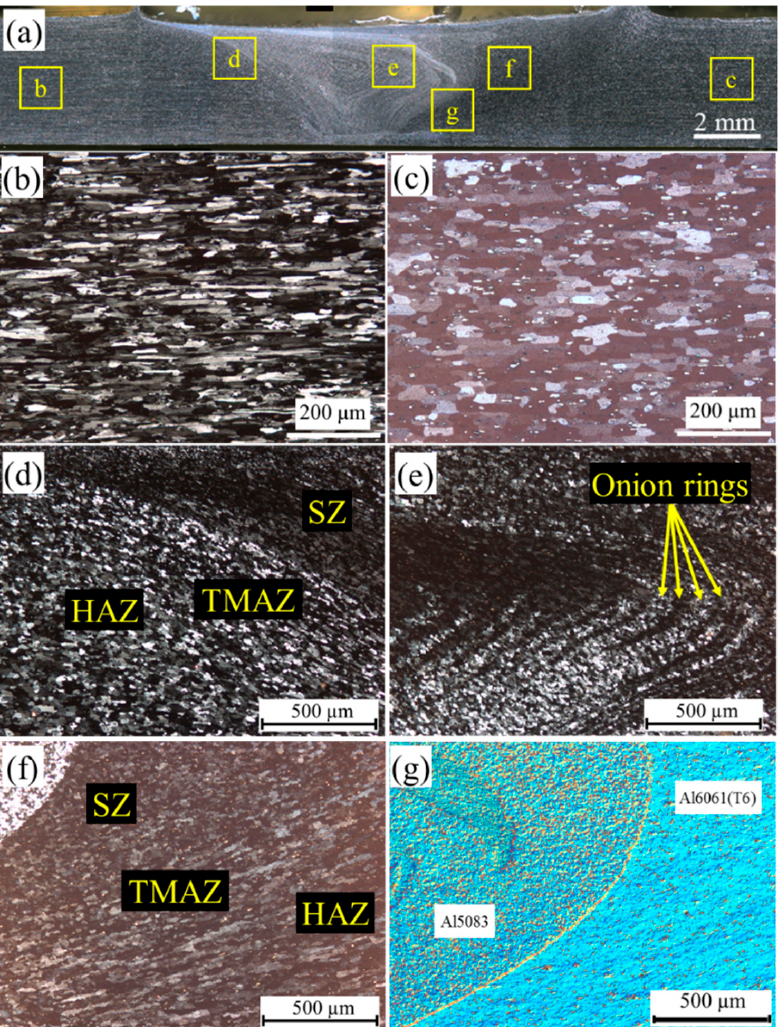
Figure 3. Microstructure of the dissimilar joint of Al5083-Al6061(T6) at Sample C-1; ( a ) cross-sectional view, ( b ) Al5083-BM, ( c ) Al6061(T6)-BM, ( d ) AS, ( e ) SZ, ( f ) RS, and ( g ) differential interference contrast (DIC) image of SZ.